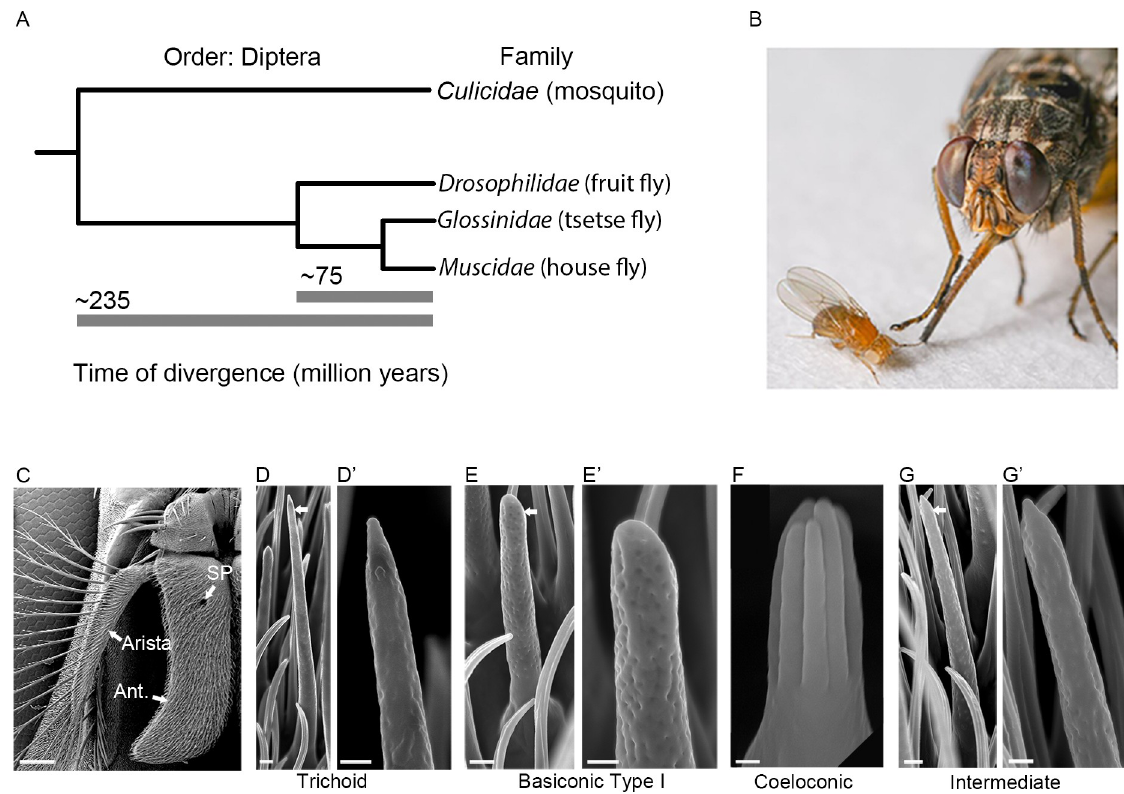
Fig 1. The relationship of Glossina morsitans to Drosophila melanogaster and its antennal sensilla. (A) Phylogenetic tree showing the evolutionary relationship among four families within the order Diptera: Culicidae, Drosophilidae, Glossinidae, and Muscidae. Estimated divergence times are from Wiegmann et al., 2011 [4]. (B) Photograph of D . melanogaster and G . m . morsitans courtesy of Dr. Geoffrey Attardo (adapted from Sun et al. 2018 [27]). (C) Scanning electron micrograph of the antenna of G . morsitans . Arrows indicate the third antennal segment (Ant.), arista, and sensory pit (SP). Micrographs of trichoid (D, D’), basiconic (E, E’), coeloconic (F), and intermediate (G, G’) olfactory sensilla from G . morsitans . Arrows in D, E, and G indicate the sensilla that are shown at higher magnifications in the images to the right. Scale bars = 100 μ m for C; 1 μ m for D, E, G; 0.5 μ m for D’, E’, G’; and 0.25 μ m for